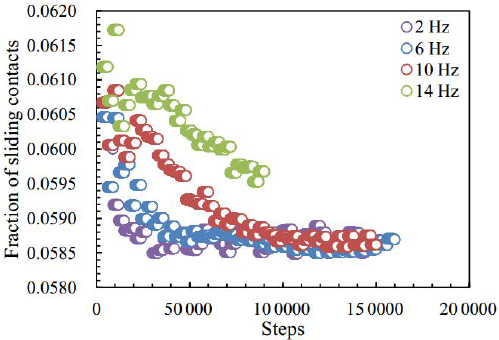
Figure 10. Fraction of sliding contacts with different